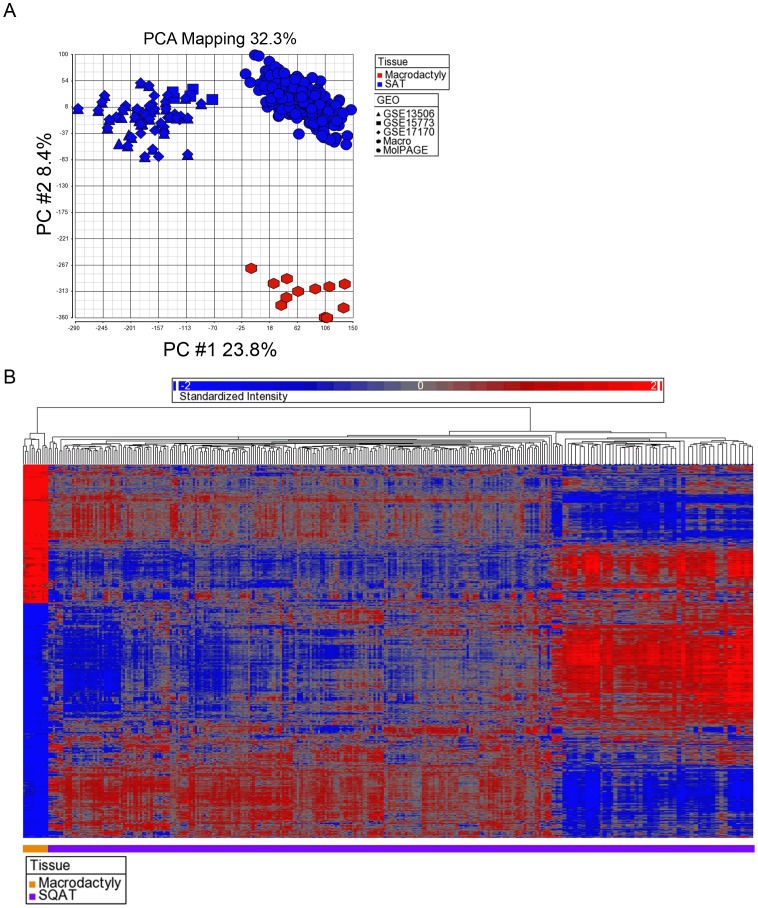
Results of principal component analysis (PCA) and hierarchical clustering of gene expression date from macrodactyly samples.(A) PCA of 4 macrodactyly samples (in triplicate) vs. 345 subcutaneous adipose tissue (SAT) samples. The top 2 vectors account 32.3% of intersample variation. Macrodactyly samples cluster distinctly from SAT. (B) Hierarchical clustering of macrodactyly and SAT samples across differentially expressed genes with fold-change >1.5, p-value <0.05, and false discovery rate <0.05. Macrodactyly samples cluster distinctly and distantly from all SAT samples.